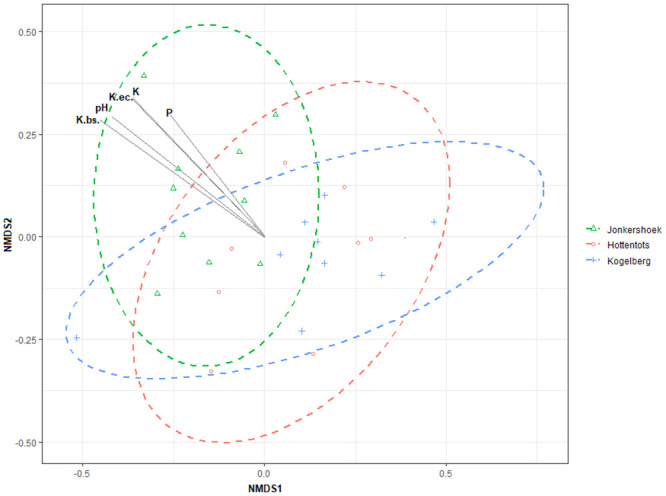
A non-metric multidimensional scaling ordination plot, based on the Bray-Curtis distance matrix, representing the acidobacterial community compositions in various samples examined in this study.Soil abiotic properties that had a significant correlation (p<0.05) with the acidobacterial communities are indicated with an overlaid bi-plot.